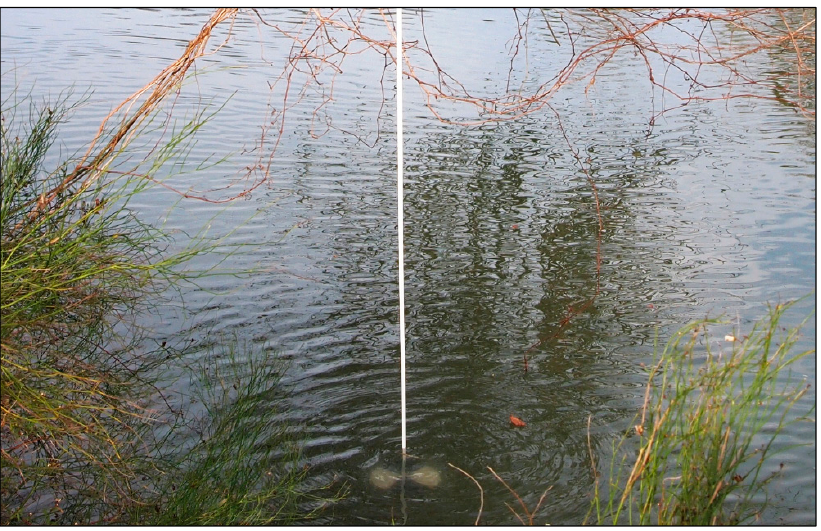
Figure 9. Freshwater Secchi disk.